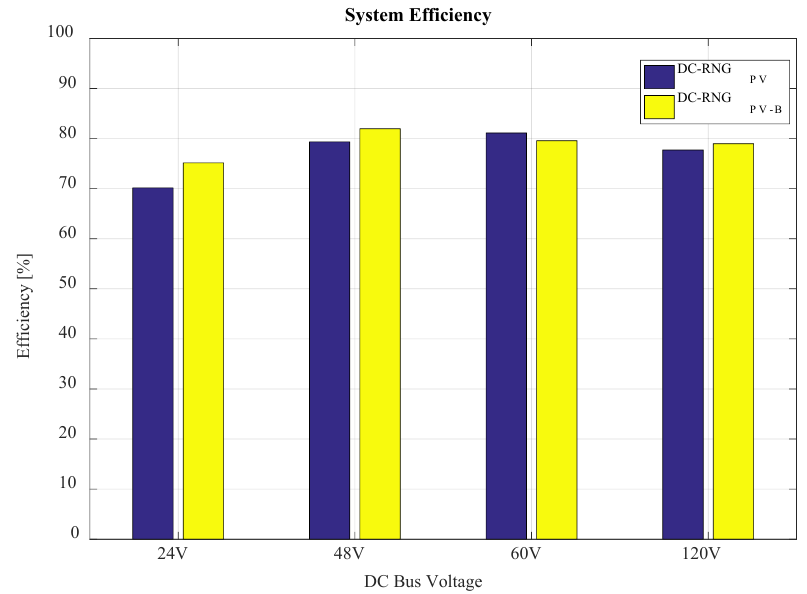
Figure 7. The DC-RNG’s efficiency for different voltage levels without and with batteries.